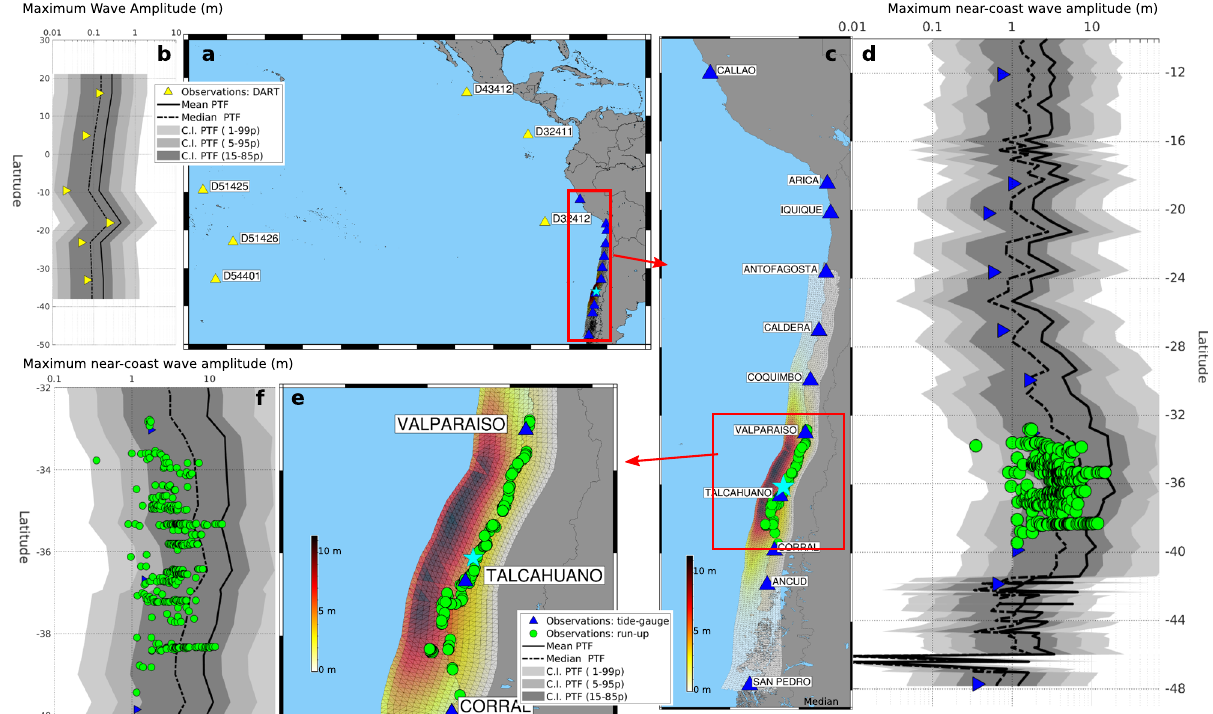
Fig. 4 PTF for the 2010 M8.8 Maule tsunami. a Epicentre and location of deep-sea (DART) observations (yellow triangles) and b corresponding comparison between deep-sea observations and PTF forecasts (black lines and grey areas). c Epicentre (star), average of the slip distributions used in the ensemble, and location of coastal observations (tide-gauges and run-up as blue triangles and green circles, respectively; run-up is halved to compare with wave amplitude, see Supplementary Note 6). d Graphical comparison between coastal observations and PTF forecasts (black lines and grey areas). e , f Same as b , c zoomed over the area with run-up